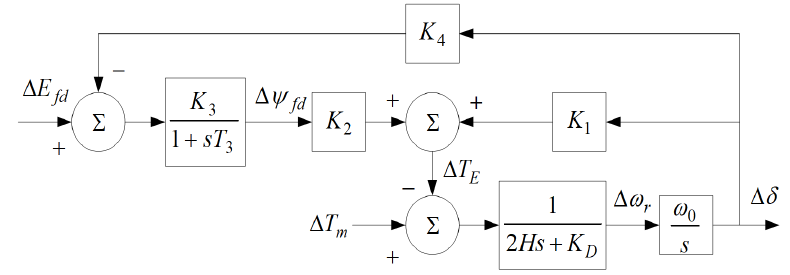
Figure 5. Philips–Heffron block diagram